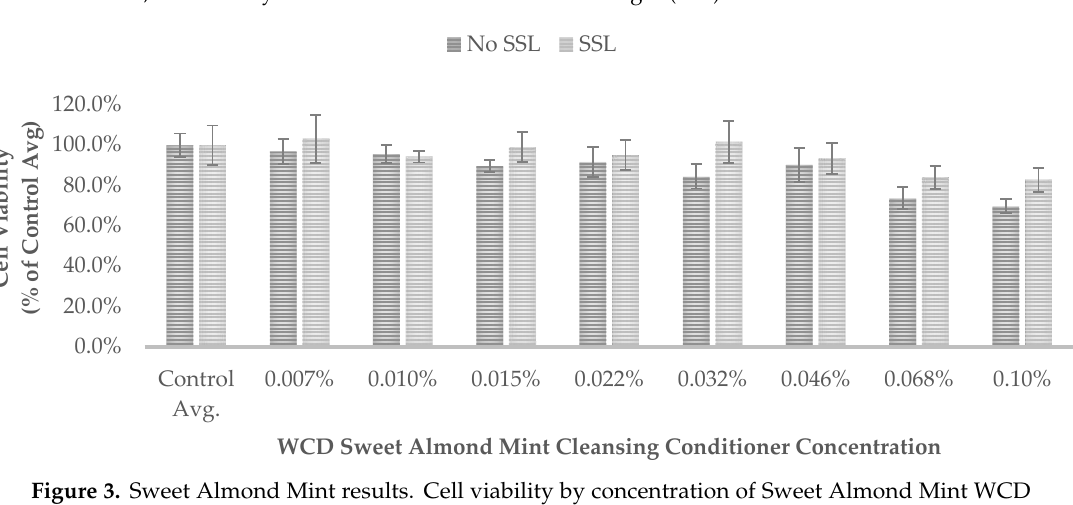
Figure 3. Sweet Almond Mint results. Cell viability by concentration of Sweet Almond Mint WCD cleansing conditioner, stratified by with and without solar simulated light (SSL).